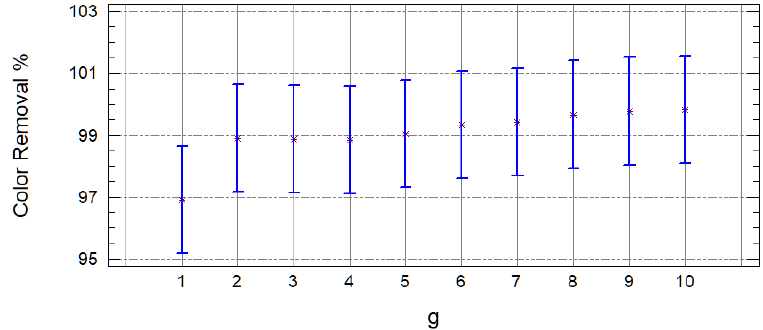
Figure 6. Mean chart of the color removal efficiency in FE, according to the amount (g) of carbon